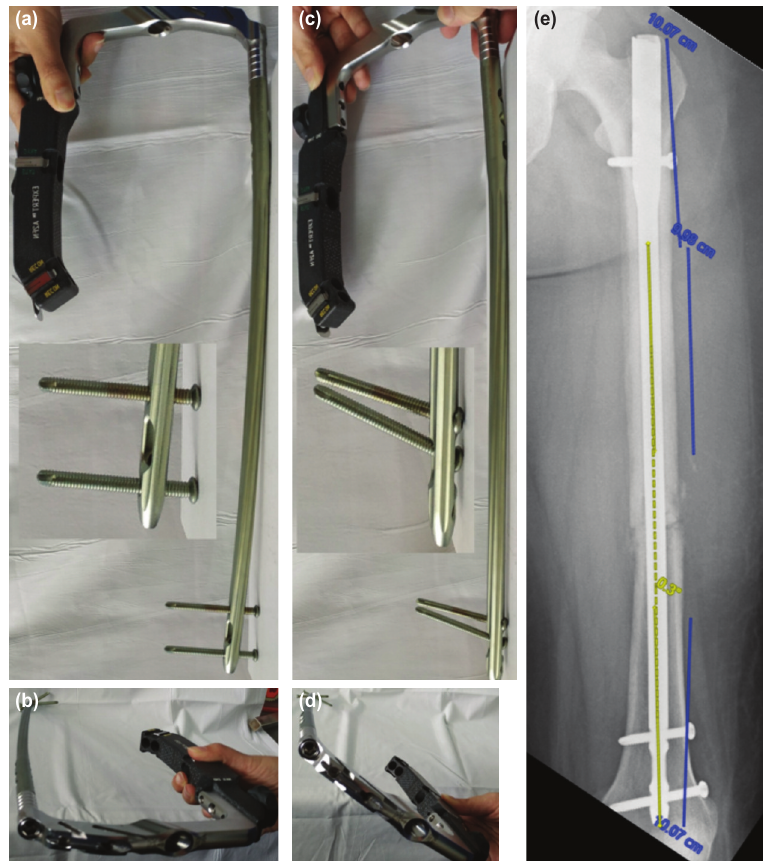
A2FN assembled to insertion handle, coronal alignments of the nail in relation to distal screws holes and insertion handle were Fig. 3: shown. (a) When distal static screws holes are in true lateral plane, the nail is valgus, and (b) the insertion handle is horizontal. (c) When distal dynamic screw hole is in true lateral plane, the nail is straight, and (d) the insertion handle is anteverted (approximately 30°). (e) An example of femoral radiograph with A2FN shows that the lower two third of nail is straight when distal dynamic hole is well